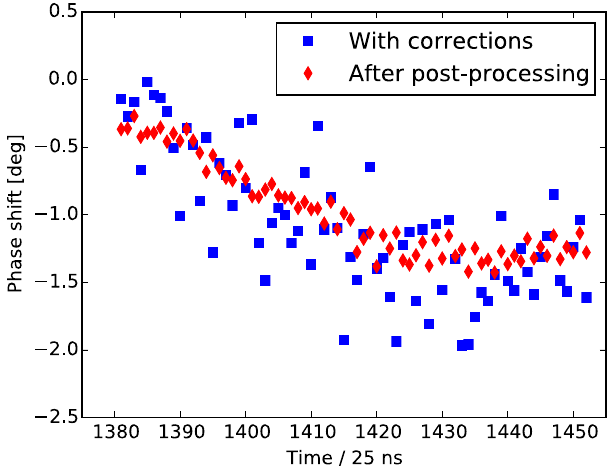
FIG. 10. Phase shift along the bunch train after corrections for systematic errors (blue squares) and after post-processing (red diamonds), applied to the same measurements shown in Fig.